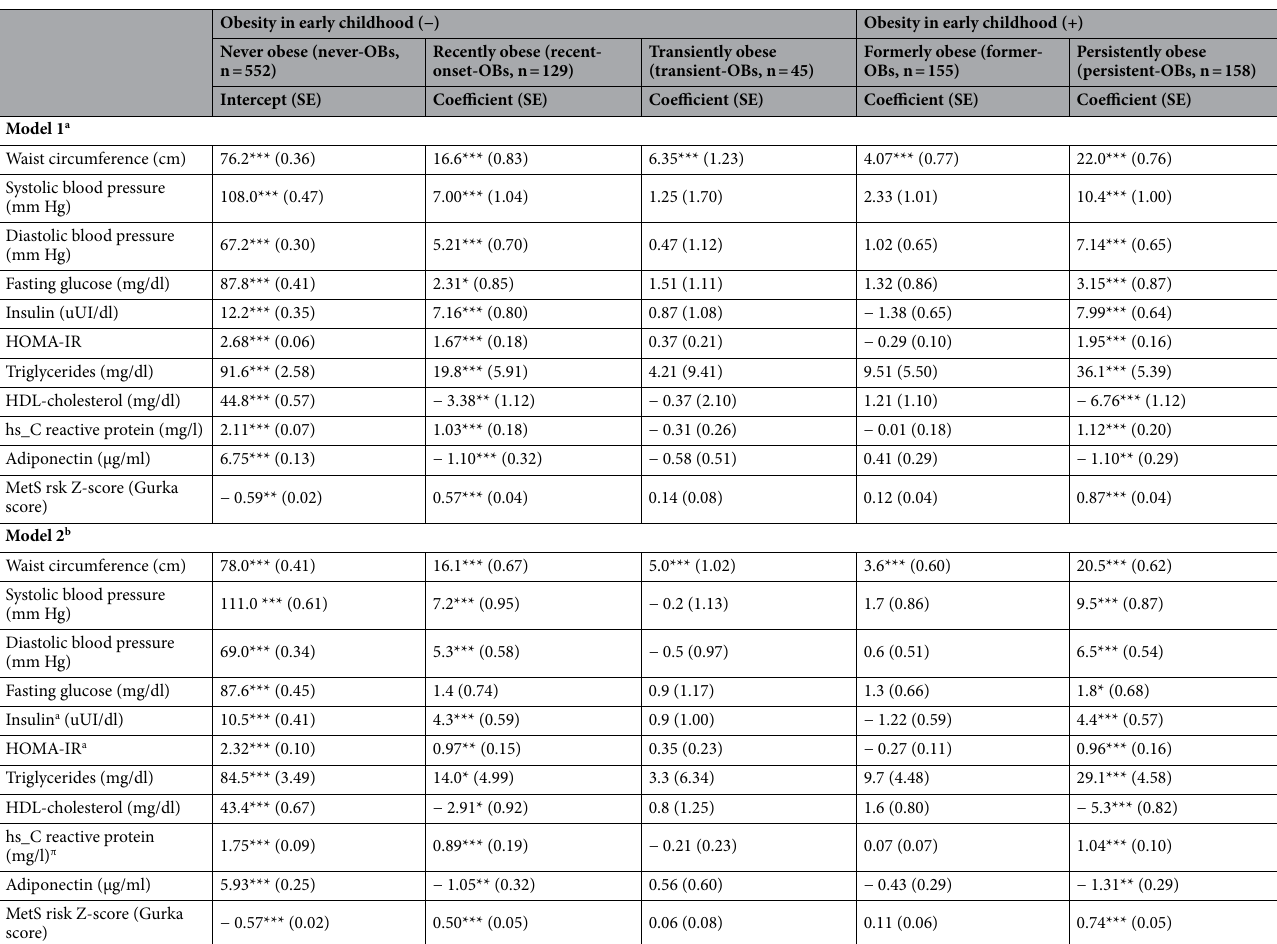
Table 2. Estimated regression coefficients examining the association of obesity timing and duration with cardiometabolic profile at 23 years (n = 1039). Coefficients are the mean difference between a given category and the reference group (Intercept, never-OBs). a Model 1 is non-adjusted. b Model 2 adjusted for sex and IR (HOMA-IR ≥ 2.6) at 23 years, except as indicated. a Models adjusted for sex and MetS status at 23 years. Statistical significance: *** P < 0.001; ** P < 0.01; * P < 0.05. Obesity in early childhood defined as having a BMI-z 2 SD above the WHO growth standard before the age of 6 years. π Participants with hs_CRP > 9 (mg/l)